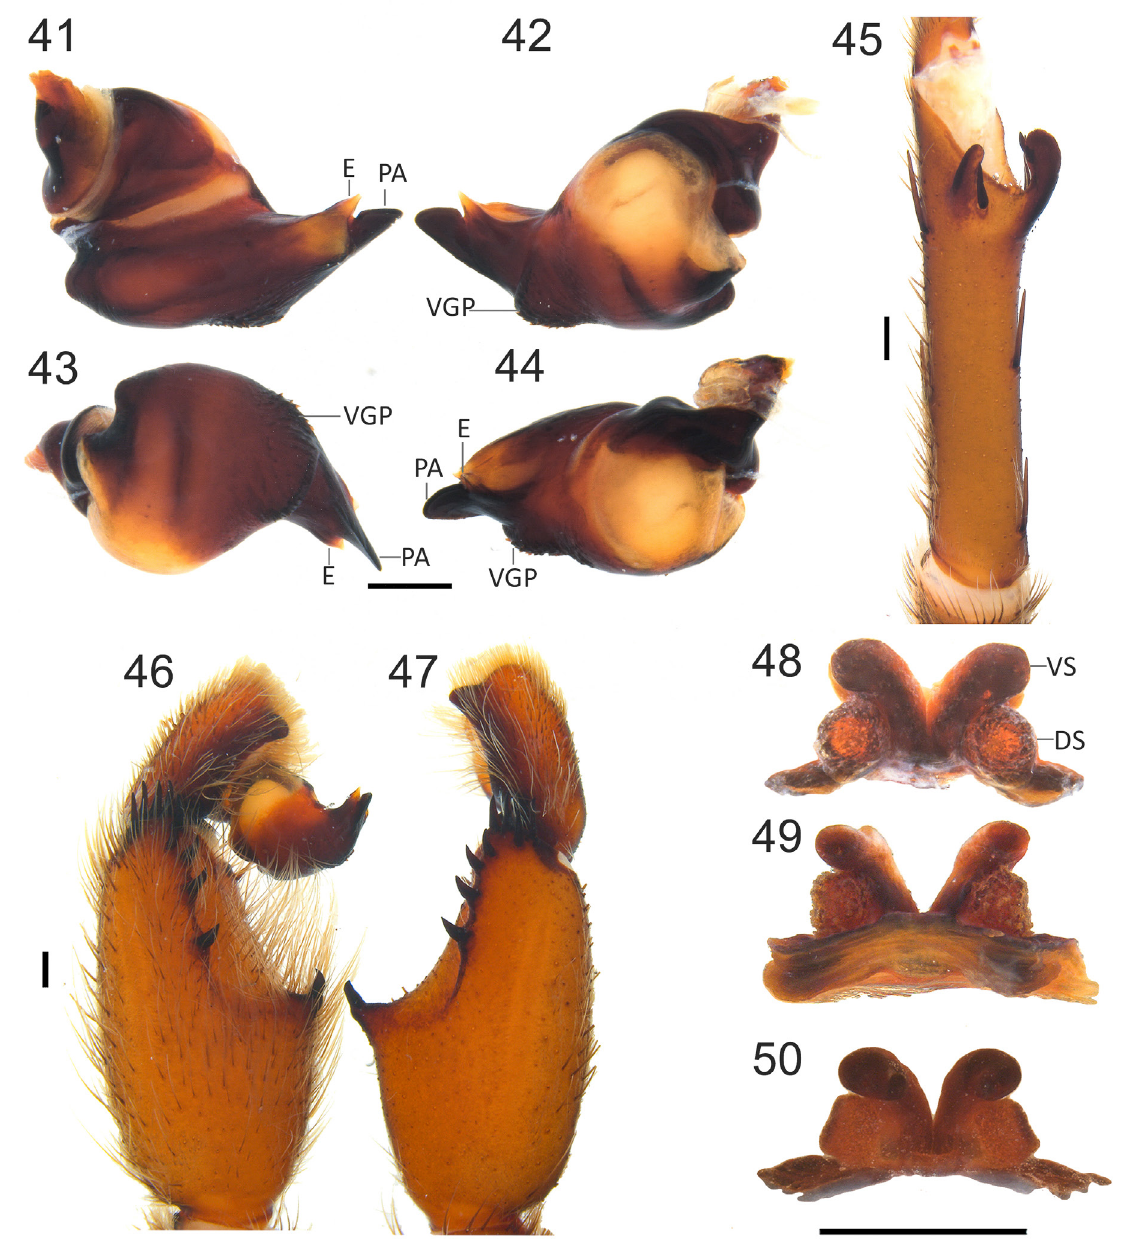
Figs 41–50 . Schismatothele merida sp. nov. 41–47 . Holotype, ♂ (MZSP 28411). 41–44 . Palpal bulb, prolateral (41), retrolateral (42), ventral (43), and dorsal (44) views. 45 . Tibial spur, ventral view. 46– 47 . Palpal tibiae, right (46), and left (47). 48–50 . Paratypes, ♀, spermathecae, ventral view. 48 . MZSP 28412. 49 . MZSP 28422. 50 . MZSP 28421. Abbreviations: DS = dorsal receptacle; E = embolus; PA = paraembolic apophysis; VGP = ventral granular process; VS = ventral receptacle. Scale bars = 0.5